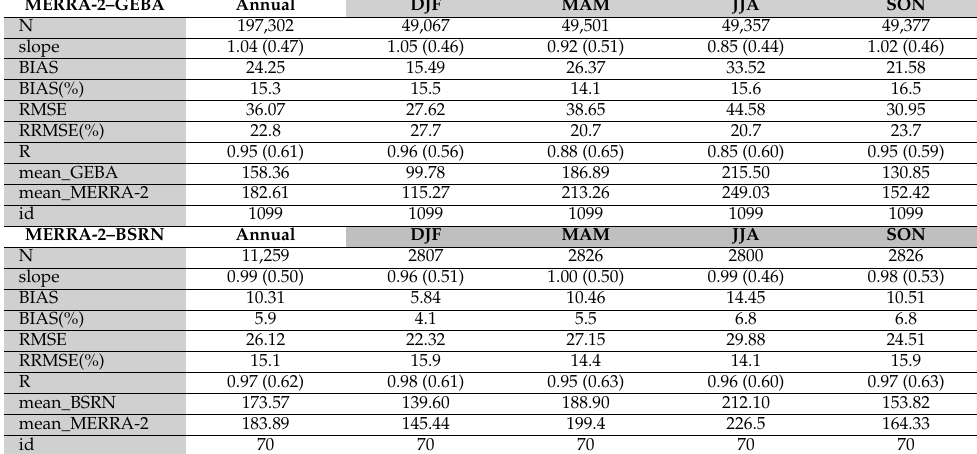
Table 1. Comparison between MERRA-2 and GEBA/BSRN SSR on an annual and seasonal basis, along with the computed main statistical parameters (number of matched data pairs, N, slope value of applied linear regression fit, absolute and percent relative biases of MERRA-2 relative to the mean GEBA/BSRN values, root mean squared error, RMSE, percent relative RMSE (RRMSE) with respect to the mean GEBA/BSRN values, correlation coefficient, R, the mean GEBA and BSRN values and the number of available stations, id, whose SSR measurements are used in the comparison). In addition, the R and slope values computed using deseasonalized SSR anomalies are given in